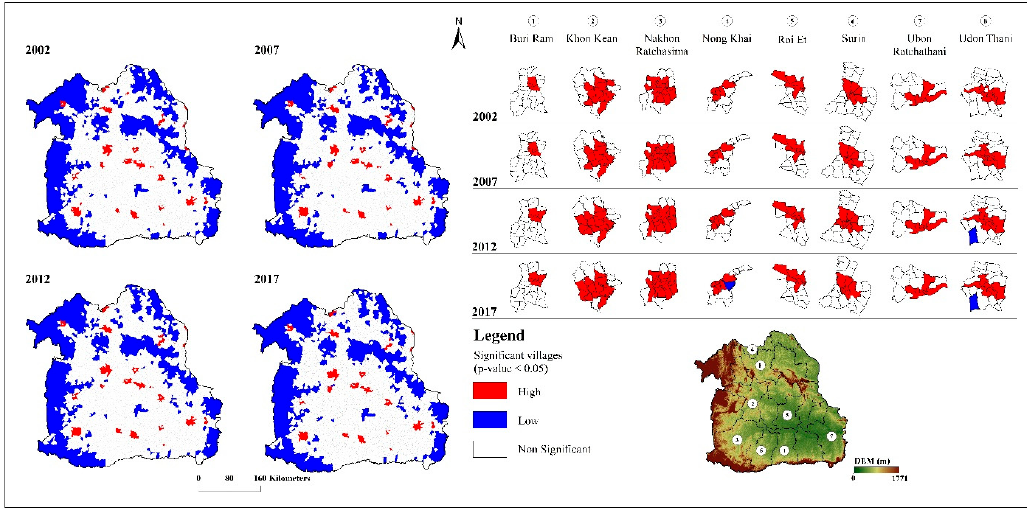
Figure 3 . Local spatial autocorrelation (local Moran’s I) of the Northeast during 2002–2017.